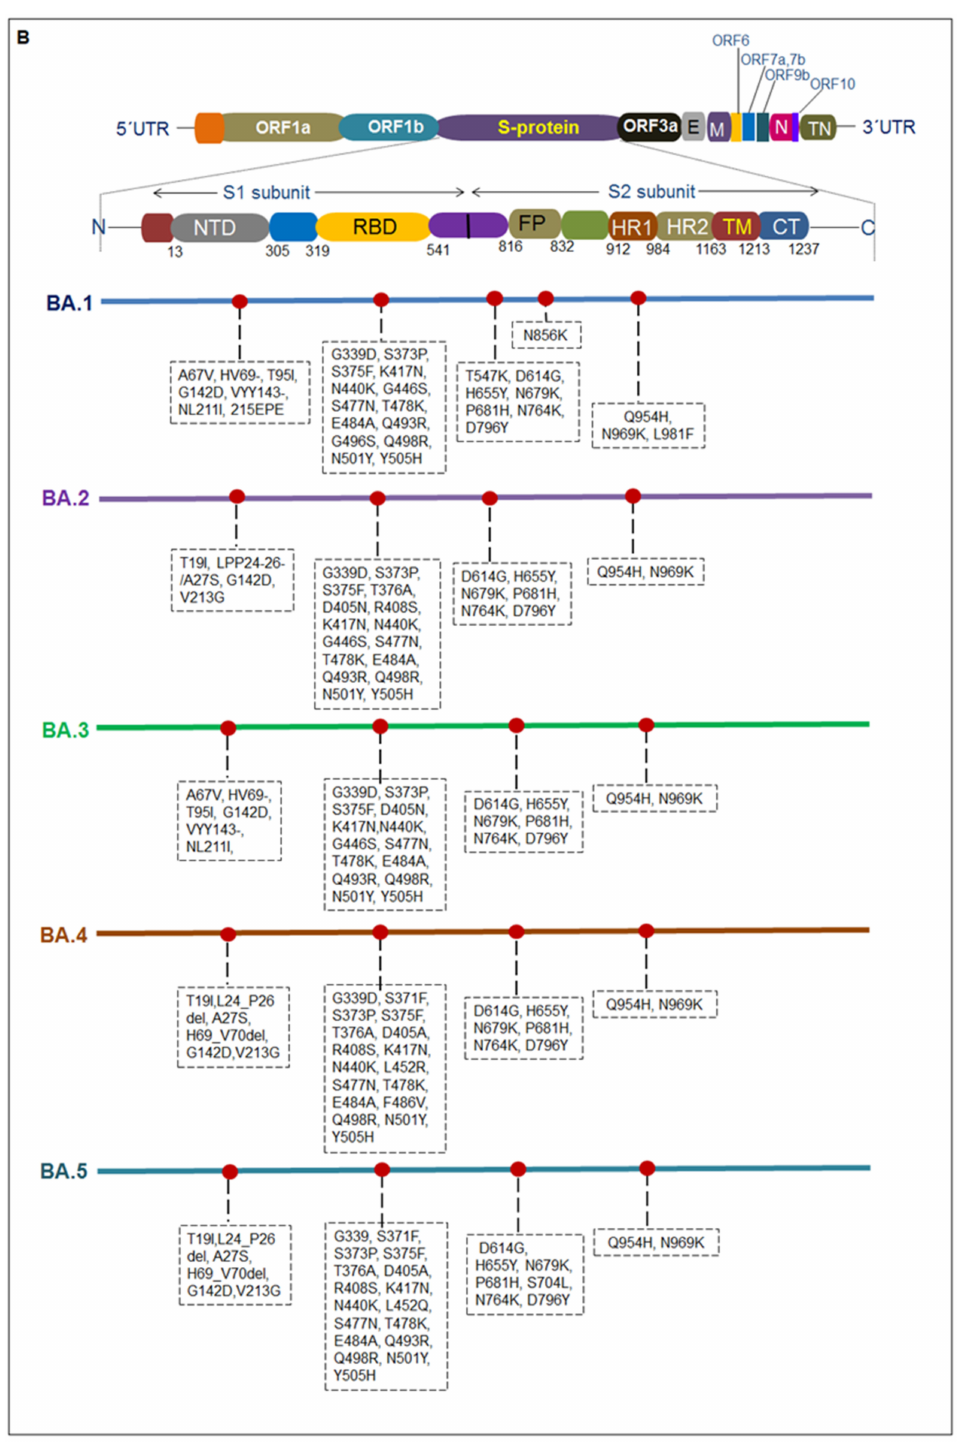
Figure 3. The figure illustrates different sub-variants of Omicron and their significant mutations in S-glycoprotein. ( A ) The figure describes different sub-variants of Omicron and their features. It describes the features of BA.1, BA.2, BA.3, BA.4, and BA.5. ( B ) The figure illustrates different mutations in S-glycoprotein of different sub-variants of Omicron. It describes the S-glycoprotein mutations of BA.1, BA.2, BA.3, BA.4, and